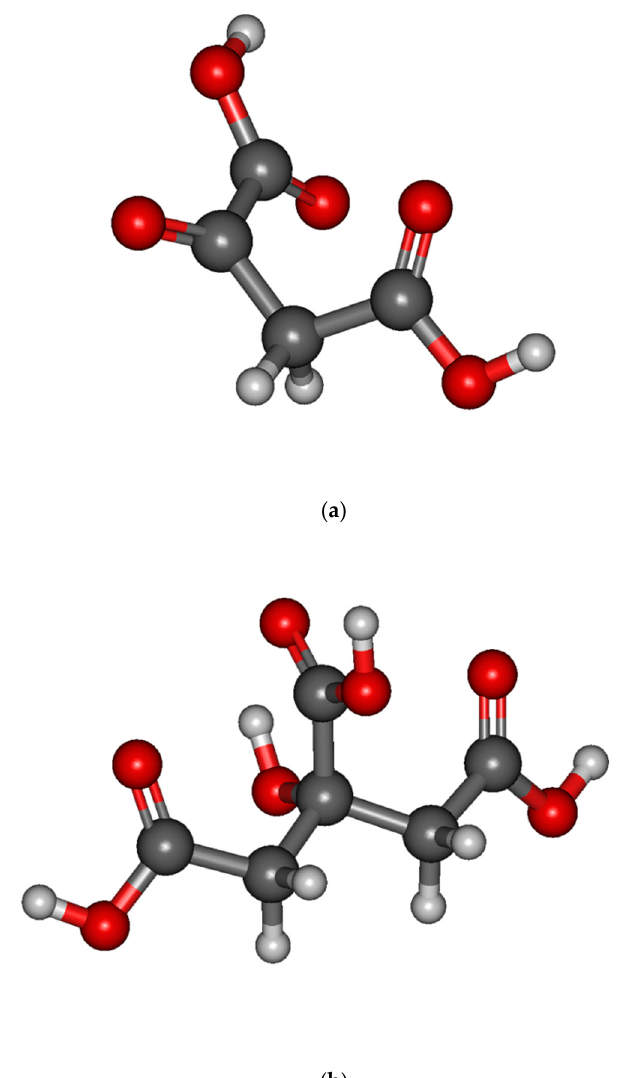
Figure 1. Optimized structure of the ( a ) neutral cis-enol oxaloacetic acid, ( b ) citric acid. The molecules were optimized at the ω B97x/cc-pvtz level of theory at 0 K.